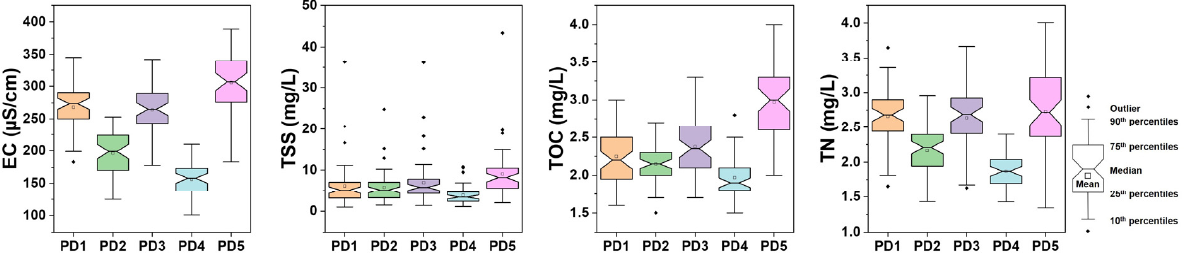
Figure 4. Boxplot graph of water quality parameters that affect the calculation of the RTWQI.